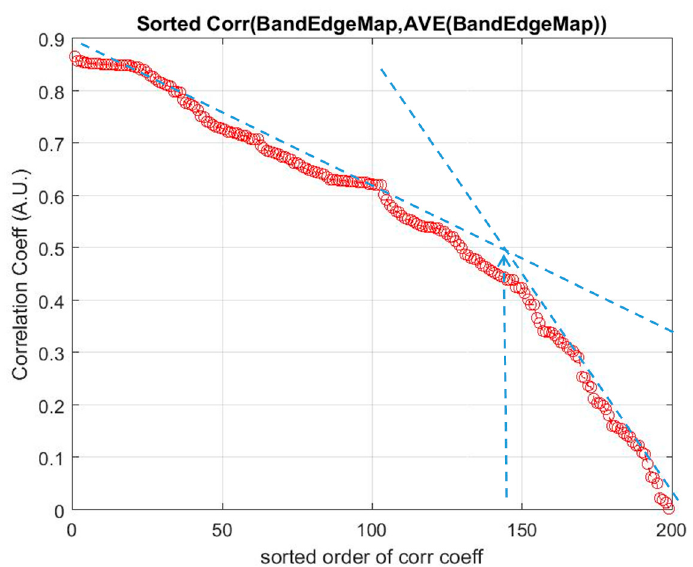
Figure 4. The spatial preprocessing technique (see Section 2.3) eliminates the non-discriminative bands through the abrupt change (blue arrow) of the correlation coefficients C i of the edge map of each band, w.r.t.: The mean of all the edge maps in the dataset (Indian Pines). The abrupt change of the ranked C i is detected automatically, and all bands beyond this point are discarded.